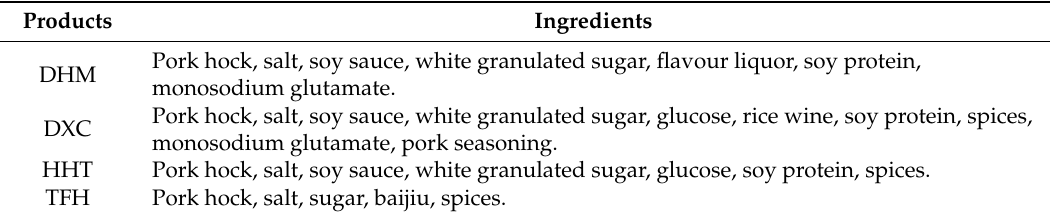
Table 3. Ingredient composition of different marinades based on the product